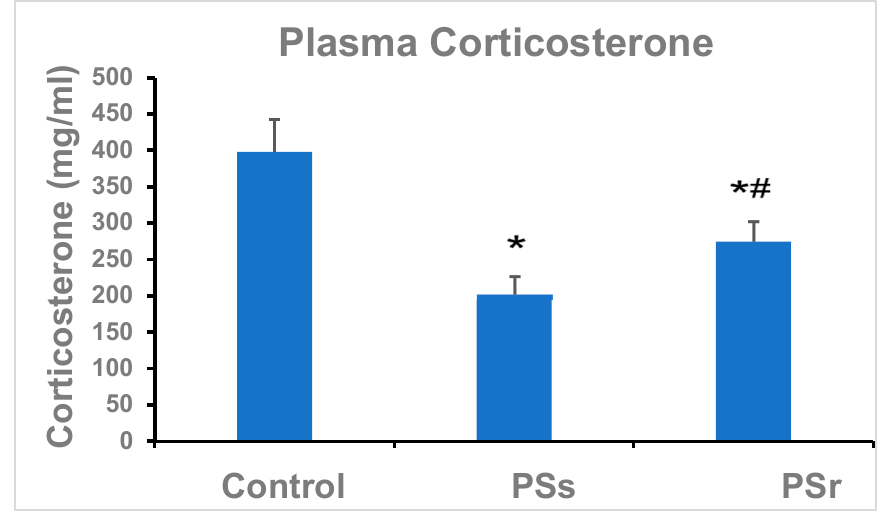
Figure 4. Effect of PS on plasma corticosterone concentration in plasma of control rats (n = 20), PS-susceptible rats (PSs, n = 9), and PS-resilient rats (PSr, n = 11). * Difference from control, p < 0.001. # Difference from PSs, p < 0.001).